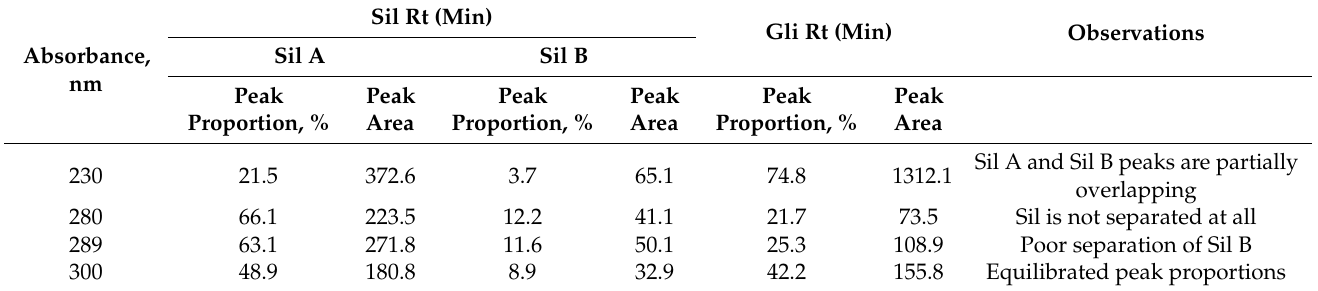
Table 3. The proportion of the peak area in relation to the total interest peak